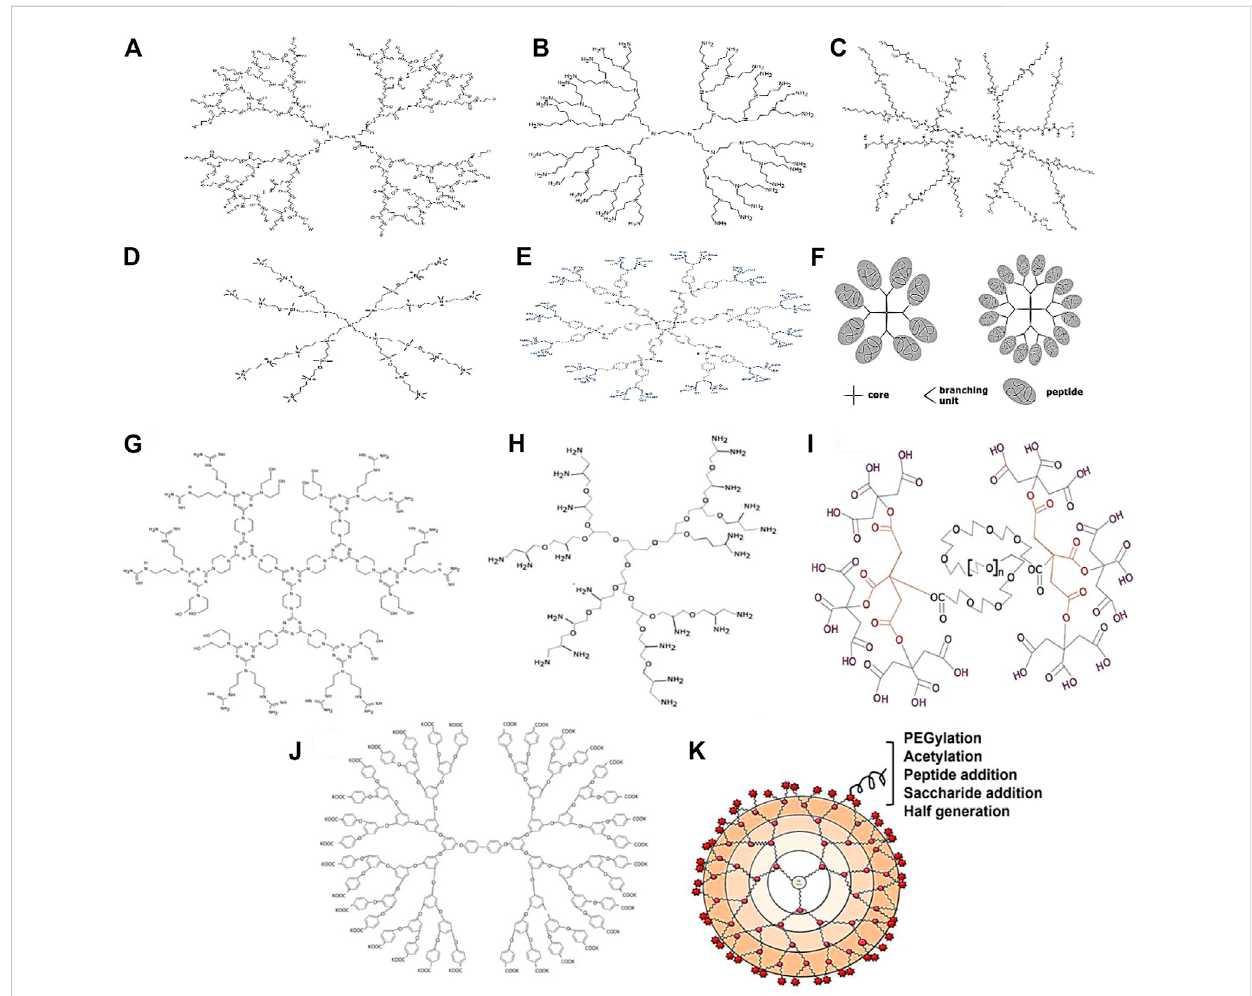
FIGURE 3 Typesofdendrimers: (A) PAMAM Dendrimers; (B) PPIDendrimers; (C) PLLDendrimers; (D) CarbosilaneDendrimers; (E) PhosphorusDendrimers; (F) Peptide dendrimers. Types of dendrimers: (G) Triazine dendrimers; (H) Polyglycerol dendrimers; (I) Citric acid dendrimer; (J) Polyether dendrimers; (K) Surface engineered